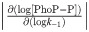
Combination of positive and negative feedback increases range of sensitivity to signal.A—steady state response of simulated promoter output (YFP, normalized to high Mg2+ YFP) for models with no positive feedback (black), no negative feedback (green) and both feedback loops (blue). B- Absolute value of sensitivity (log derivative of PhoP-P with respect to k−1, |∂(log[PhoP-P])∂(logk−1)|) for model with no negative feedback (green) has the shortest range of signal sensitivity, while the wild-type model displays two phases of high sensitivity to signal.